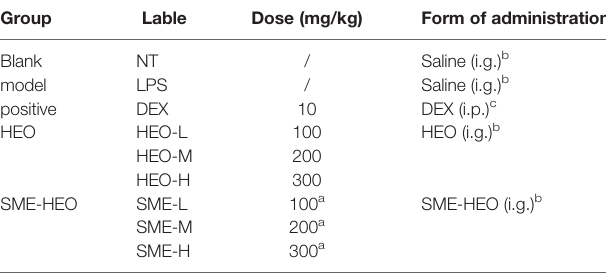
TABLE 1 | Experimental groups and drug administration.